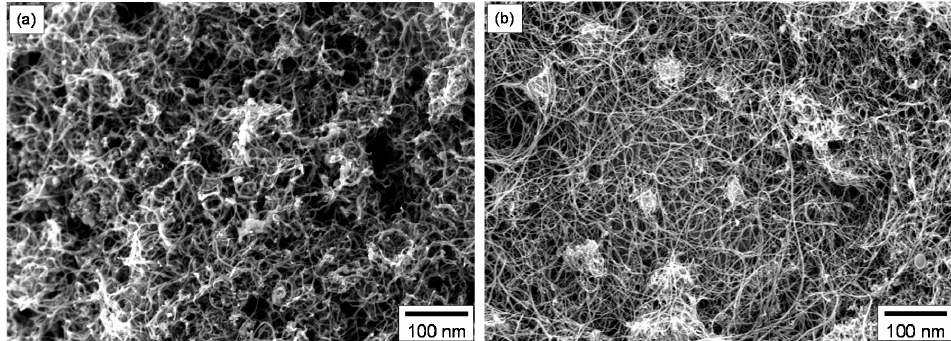
Figure 3. SEM images of bucky paper films consisting of ( a ) NC-MWCNT and ( b ) L-MWCNT.